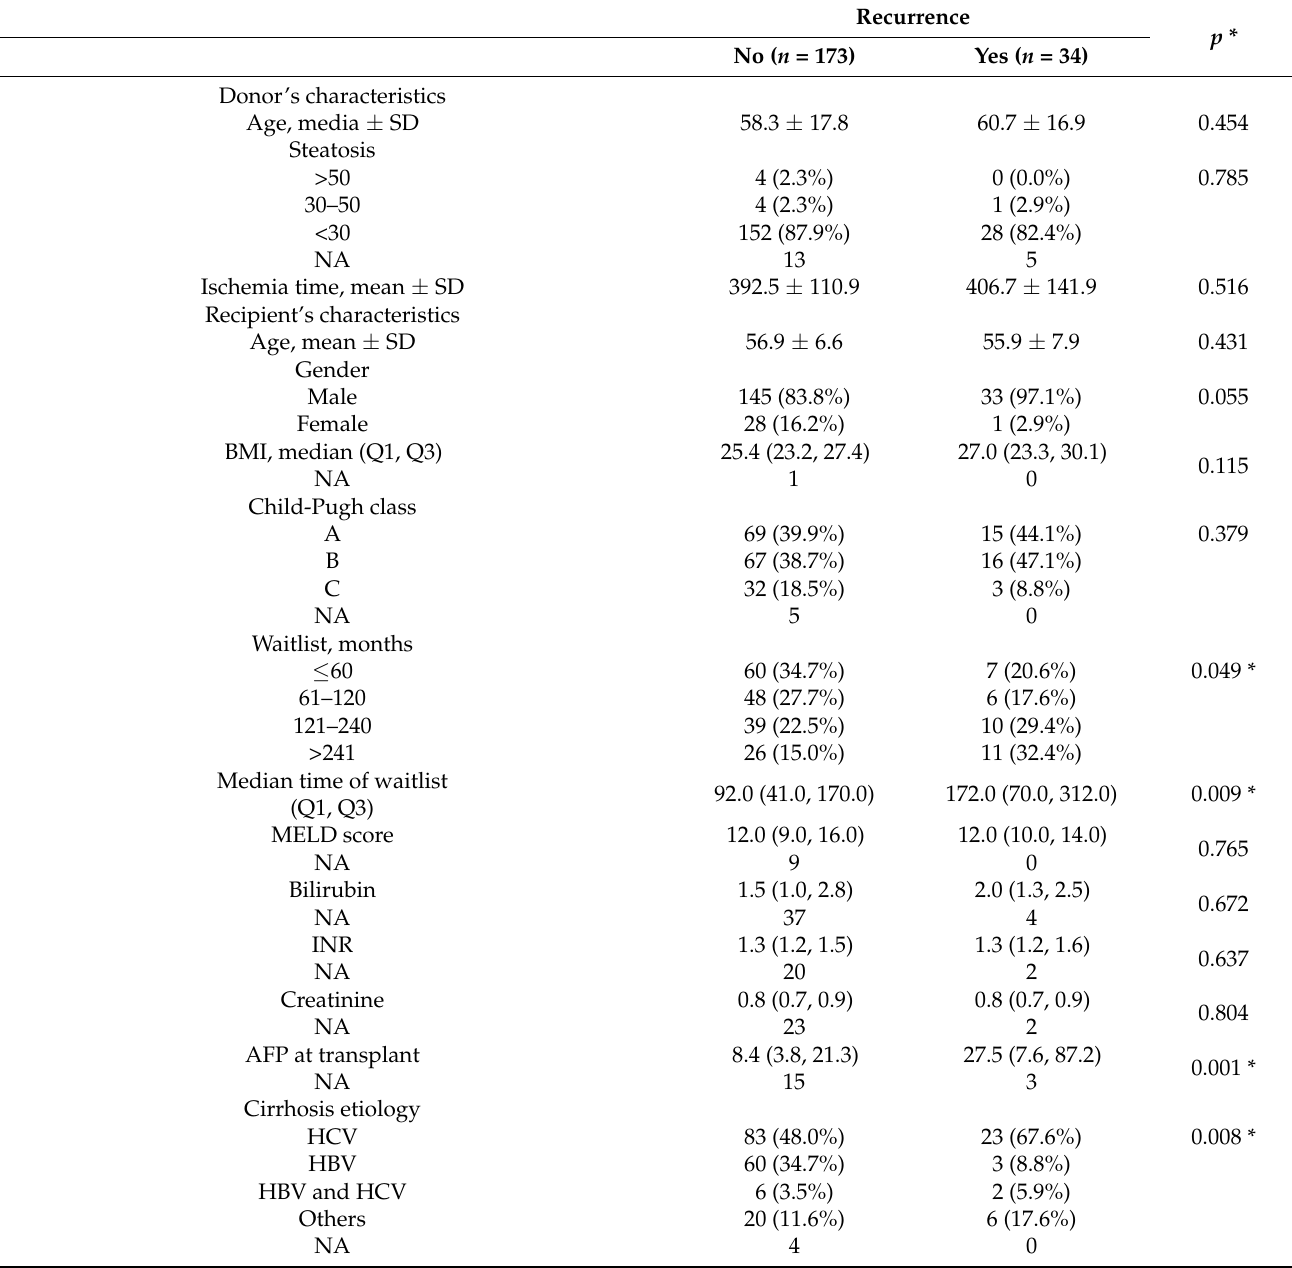
Table 1. Baseline characteristics of recipients and donors according to HCC recurrence.